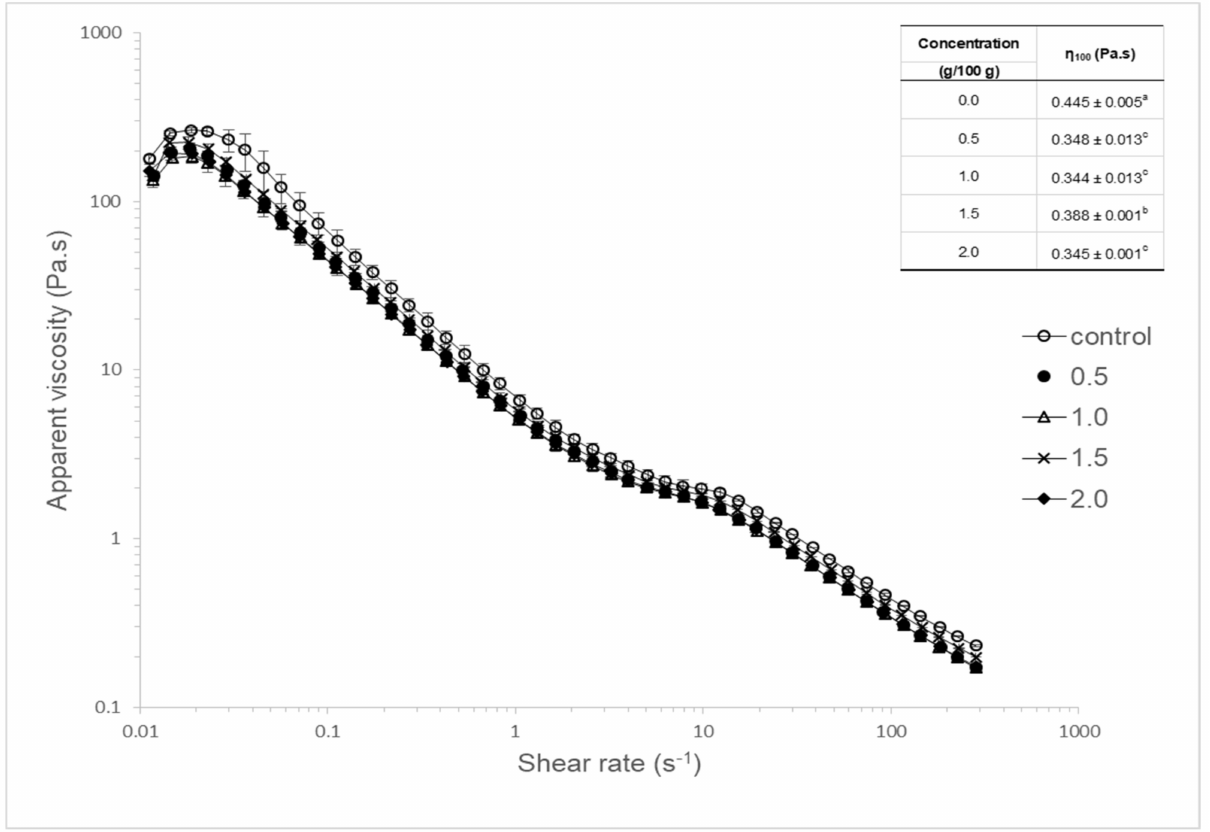
Figure 2. Apparent viscosity of sweetened plain whole-fat yogurts with addition of jabuticaba skin powdered extract at different concentration levels (control-0.0, 0.5, 1.0, 1.5, and 2.0 g/100 g) after 14 days of refrigerated storage with increasing shear rate (up flow curve). Apparent viscosity at a shear rate of 100 s − 1 ( η 100 ). Means ± standard deviation. Means in the same column followed by same lower-case letter do not differ significantly ( p > 0.05) according to Tukey’s multiple comparison